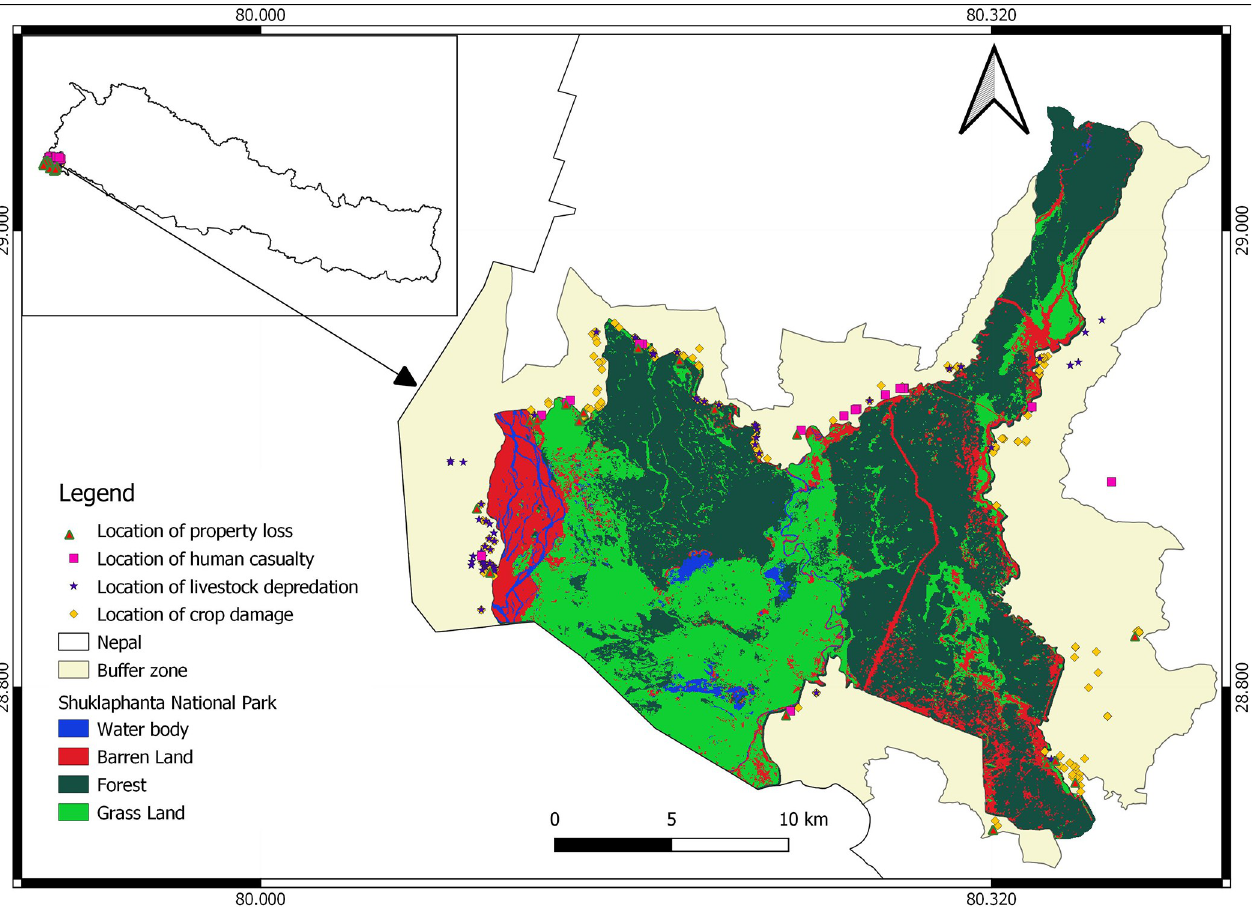
Fig 1. Shuklaphanta National Park, Nepal, with adjacent buffer zones and locations of human-wildlife conflicts, 2016–2022.